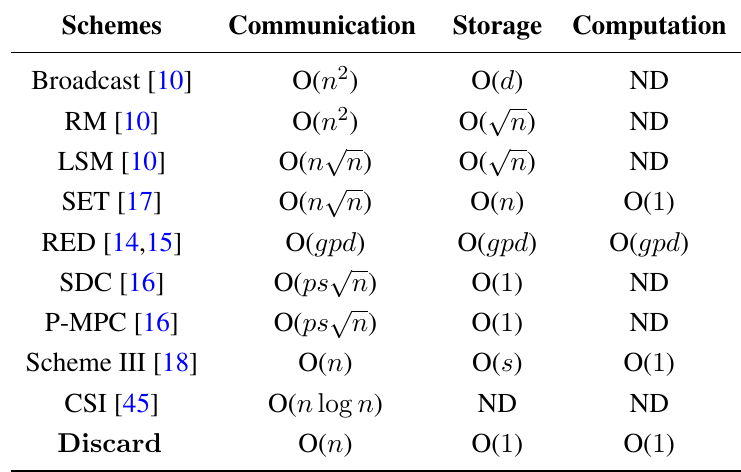
Table 1. Comparison of existing schemes vs. Discard . ND, no discussion; SDC, single deterministic cell; P-MPC, parallel multiple probabilistic